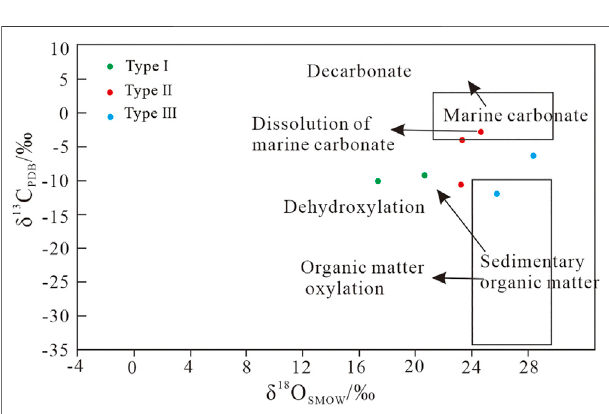
FIGURE 8 | Plot of δ 13 C PDB vs δ 18 O SMOW for the siderite samples (modi fi ed from Hoefs, 2009).